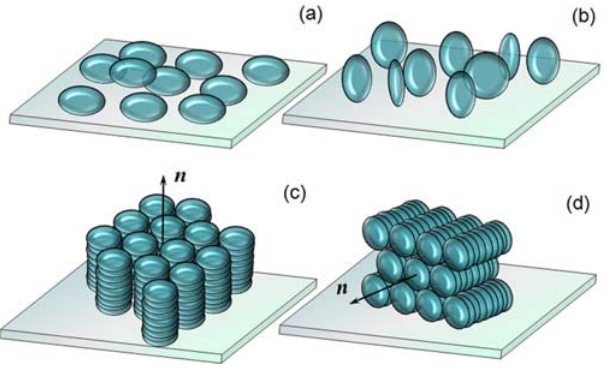
Figure 1. (a) Face-on anchoring of discotic molecules. (b) Edge-on anchoring of discotic molecules. (c) Homeotropic alignment of discotic columns. (d) Homogenous alignment of discotic